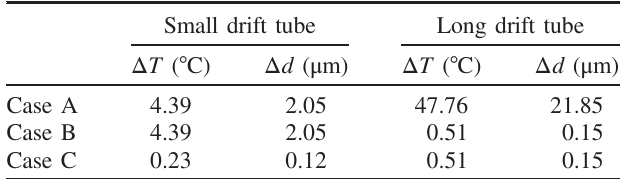
TABLE I. The maximum temperature difference and drift-tube axis displacement for all cooling strategies at a duty cycle of 10%.